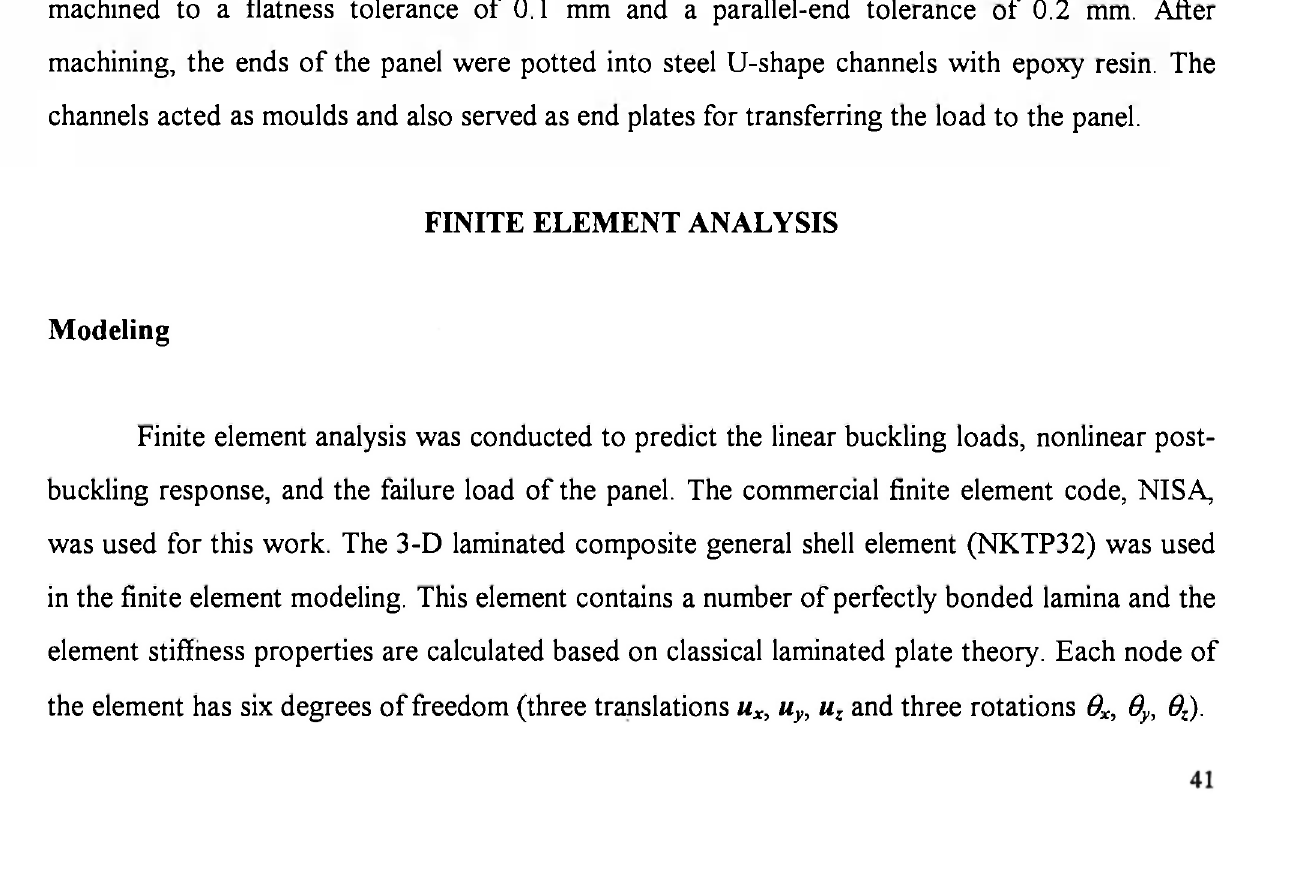
Figure 2. Tooling